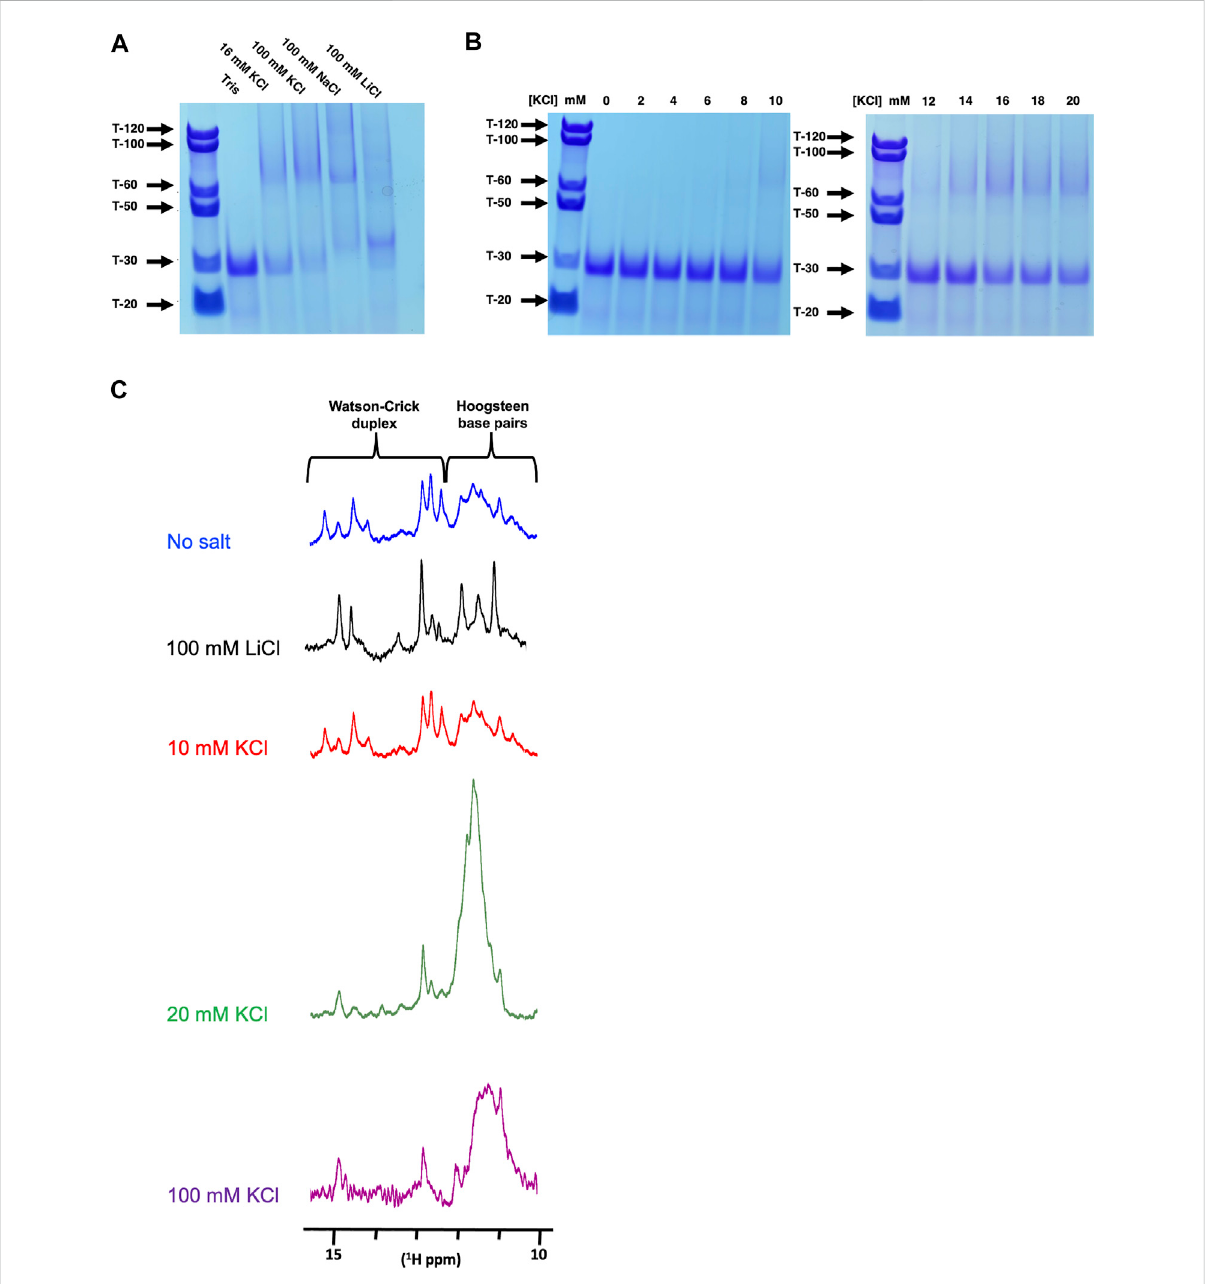
FIGURE 4 Native PAGE and NMR analysis of Q2 163 – 192 at different K + concentrations (A) 12% Native PAGE of Q2 163 – 192 RNA following incubation in the presence of Tris pH 7.0, with either no added salt, 16 mM KCl, 100 mM KCl, 100 mM NaCl or 100 mM LiCl. Poly-T of various sizes were used as molecular standards. (B) 12% Native PAGE ofQ2163 – 192 RNA following incubation inthepresence of Tris pH7.0, with increasingconcentrations of KCl (0 – 20 mM) (C) 1 H NMR ofthe wild-type Q2 163 – 192 in10 mM Tris pH 7.0, with no added salt, 100 mM LiClor variousconcentration of KCl (10, 20 and 100